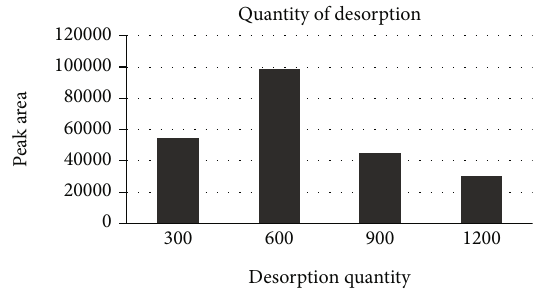
Figure 5: Graph of desorption solvent ’ s quantity.